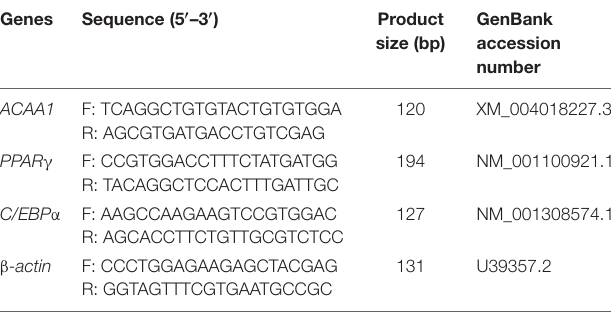
TABLE 2 | Primers used for quantitative real-time polymerase chain reaction. Genes